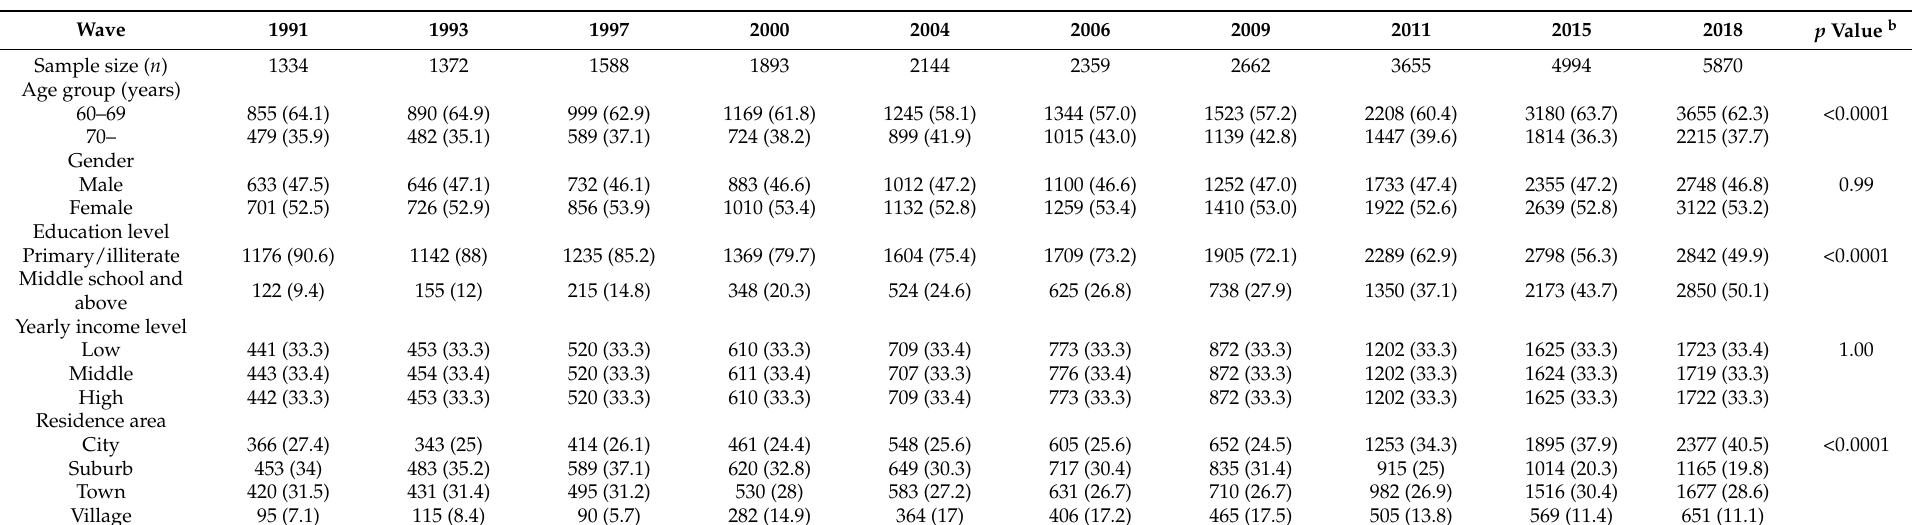
Table 1. Demographic characteristics of samples, 1991 to 2018 a